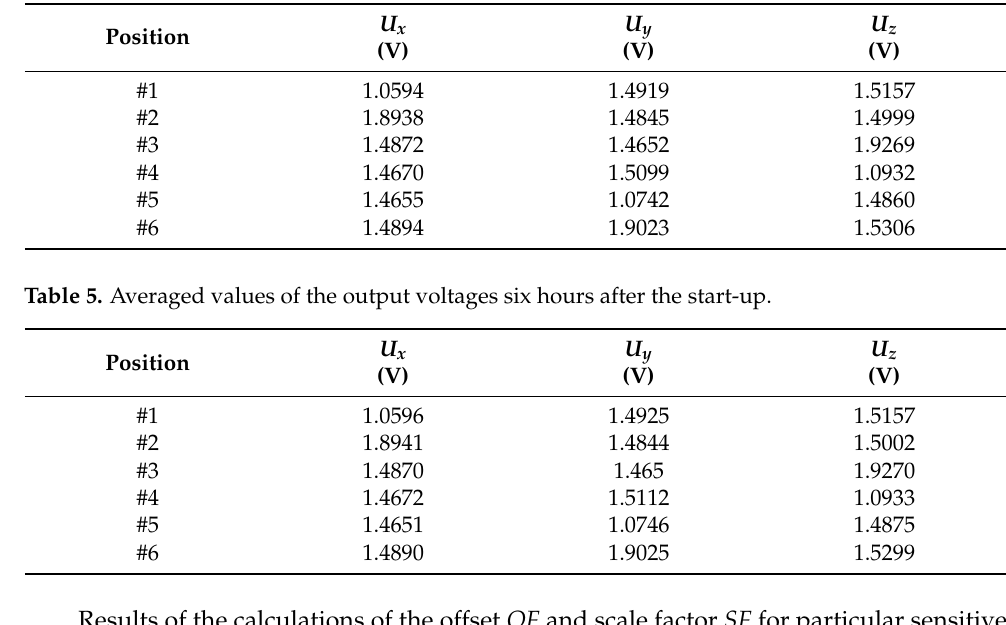
Table 4. Averaged values of the output voltages four hours after the start-up.